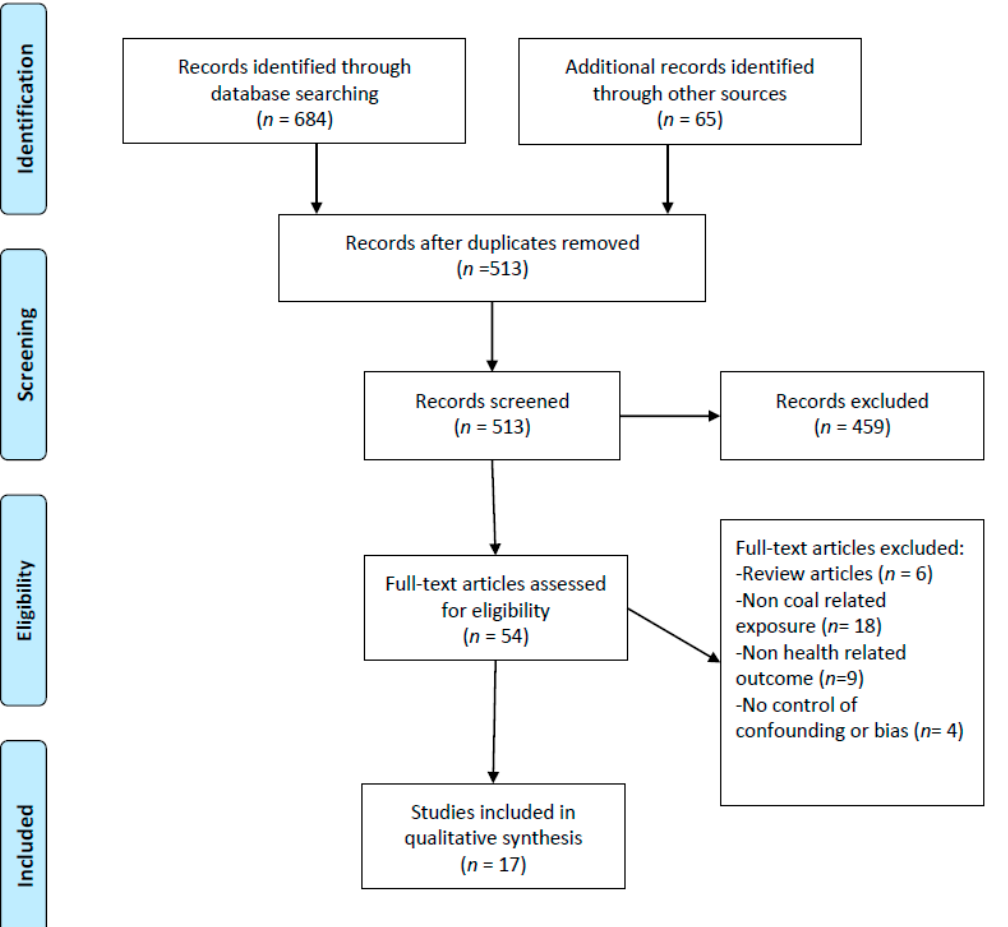
Figure 1. Flow chart of study selection, screening, and eligibility.